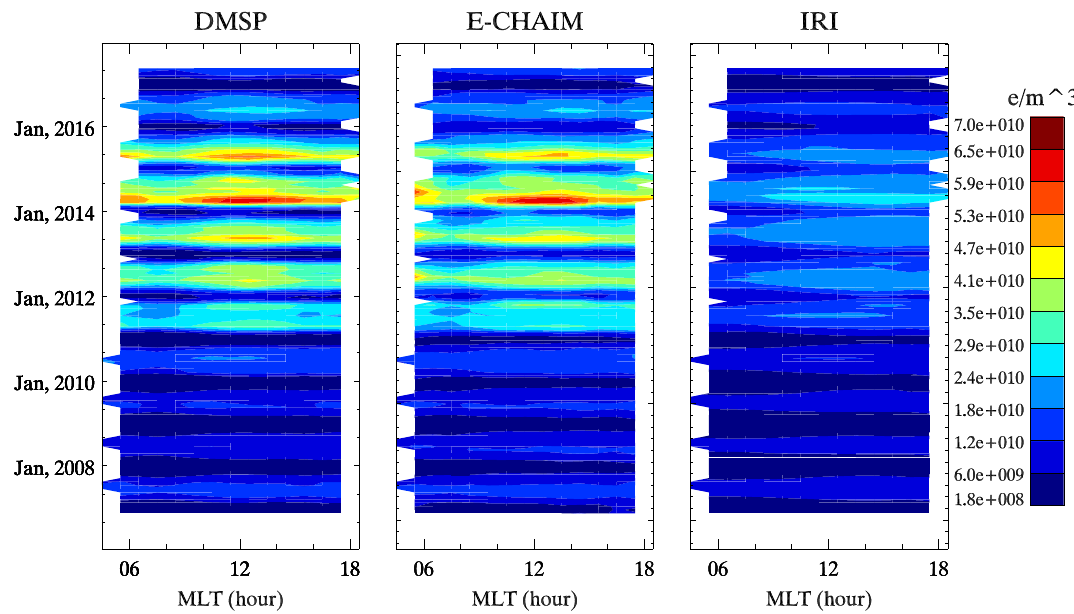
Fig. 8. Monthly median electron density from DMSP satellite F17 (left) and corresponding electron density from E-CHAIM (middle) and the IRI